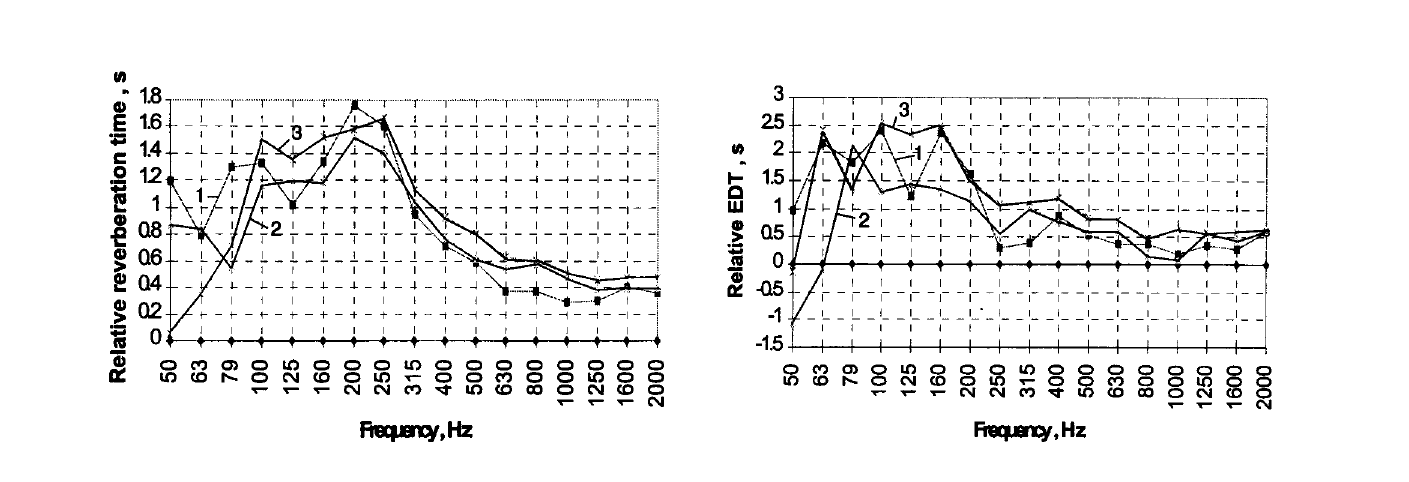
Fig. 4. The relative dependence of the hall reverberation time on the distance from the resonant suspended ceiling to the rigid ceiling surface. Slit width 100 em. Zero line corresponds to the case when no suspended ceiling is installed. 1 - distance to the rigid surface H = 100 em; 2 - 200 em; 3 - 400 em.